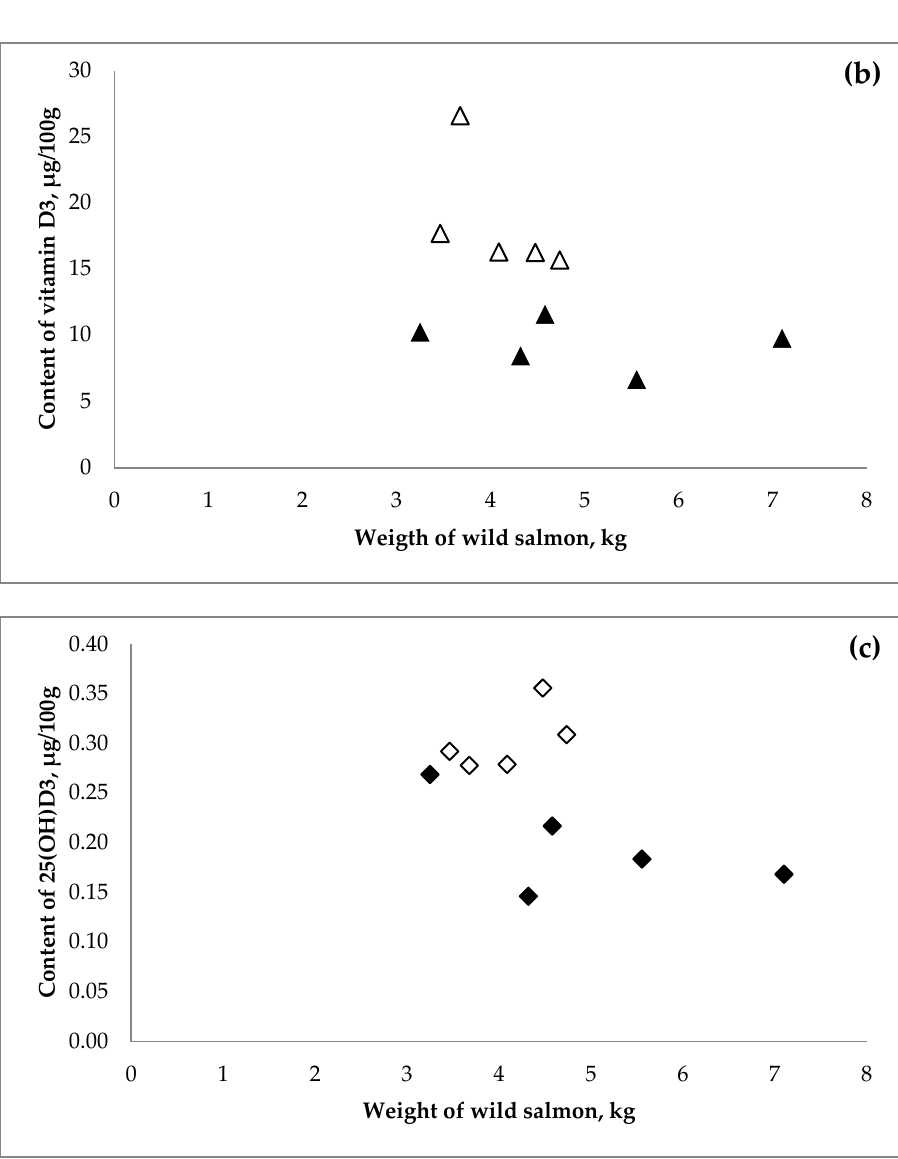
Figure 1. ( a ) Fat content in fillet as a function of weight of the wild Atlantic salmon ( Salmo salar ). Fat in salmon from the Baltic Sea ( ○ ) and from the North Sea (x). ( b ) Vitamin D 3 in fillet as a function of weight of the wild Atlantic salmon ( Salmo salar ). Vitamin D 3 in salmon from the Baltic Sea (Δ) and the North Sea ( ▲ ). ( c ) 25(OH)D 3 content of fillet as a function of the weight of the Salmo salar . 25(OH)D 3 in salmon from the Baltic Sea (◊) and the North Sea ( ♦ ).